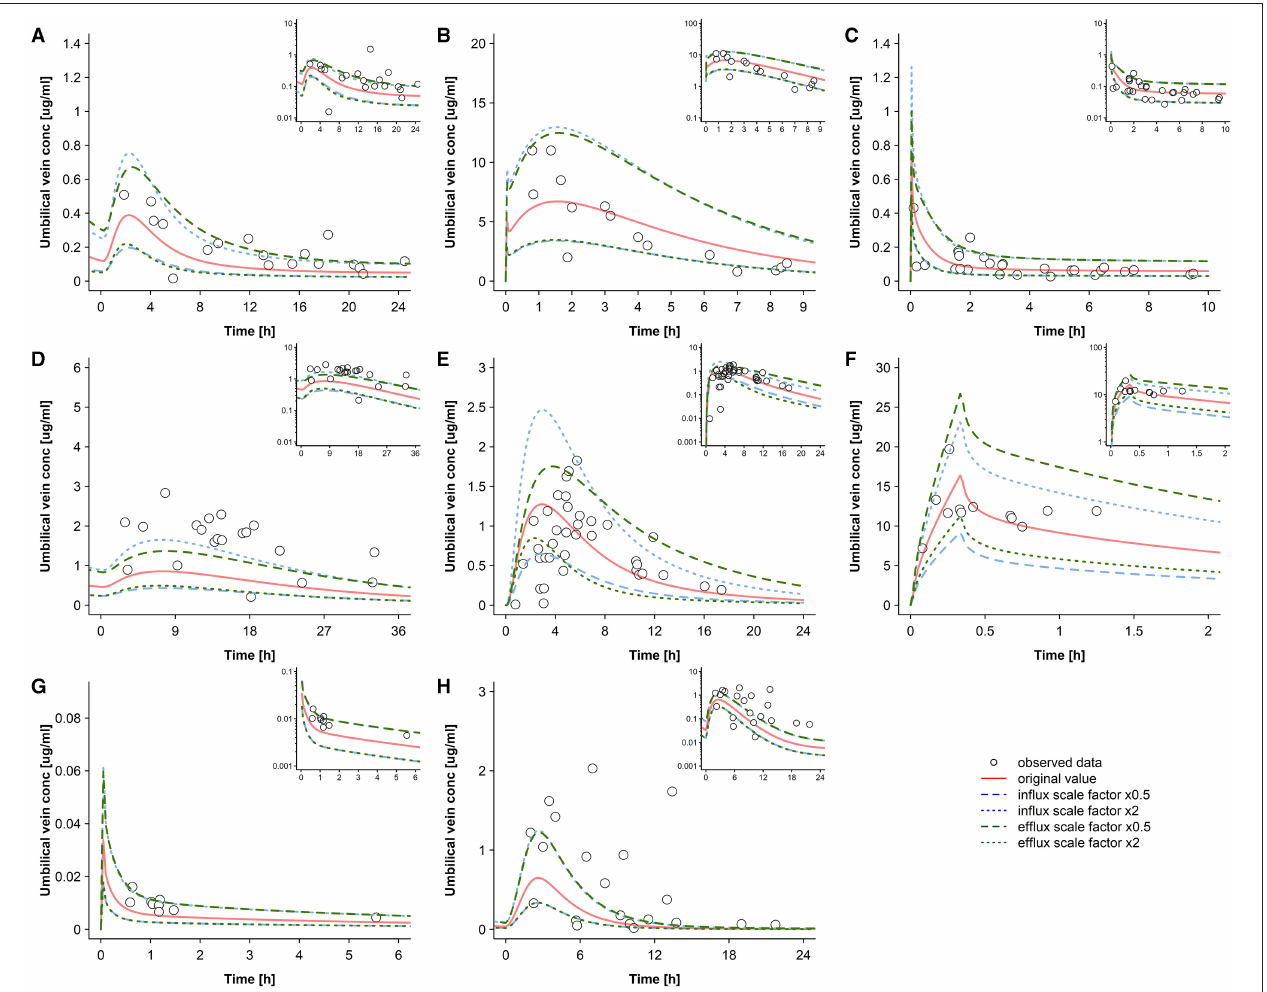
FIGURE 7 | Sensitivity analysis for the transfer clearance across the apical trophoblast membrane where either influx or efflux clearance is varied. Concentration-time profiles in the umbilical vein plasma for acyclovir (A) , cefuroxime (B) , diazepam (C) , dolutegravir (D) , emtricitabine (E) , metronidazole (F) , ondansetron (G) , and raltegravir (H) at delivery in the third trimester. Semi-log scaled figures are shown as inset plot in the top-right corner of each panel. The time refers to the time after drug administration. Circles represent individual observed data and the lines represents the predicted geomean concentrations with different transfer clearances across the apical trophoblast membrane (either influx or efflux transfer clearance is altered). Observed data for acyclovir, cefuroxime, diazepam, dolutegravir, emtricitabine, metronidazole, ondansetron, and raltegravir were taken from Liu et al. ( 18), Leung et al. (39), Hirt et al. (40), Philipson and Stiernstedt (41), De Leeuw et al. (42), Elkomy et al. (43), Visser and Hund (44), Moore and McBride (45), Ridd et al. (46), and Mandelli et al. (47), respectively. conc,